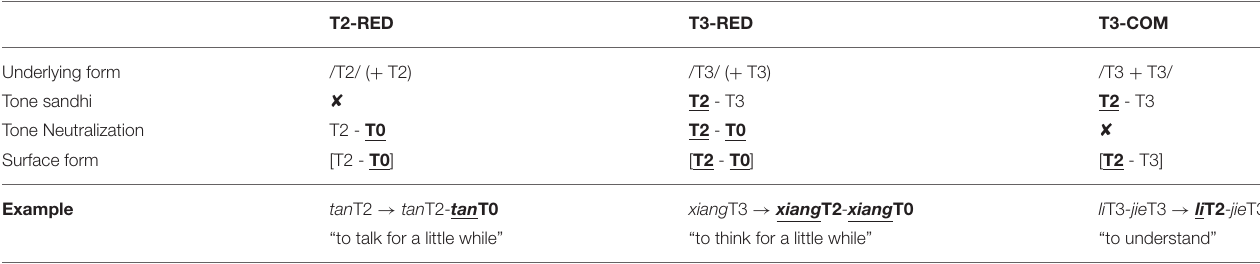
TABLE 1 | Tonal derivations of verb reduplication and lexical